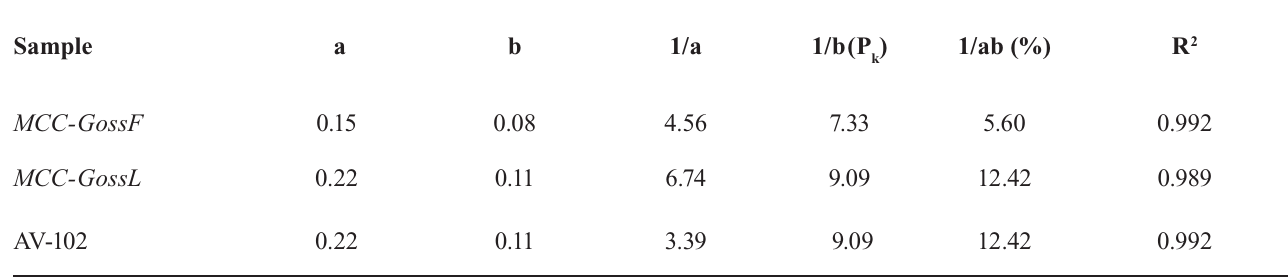
TABLE III - Compactibility and cohesiveness of microcrystalline cellulose powders